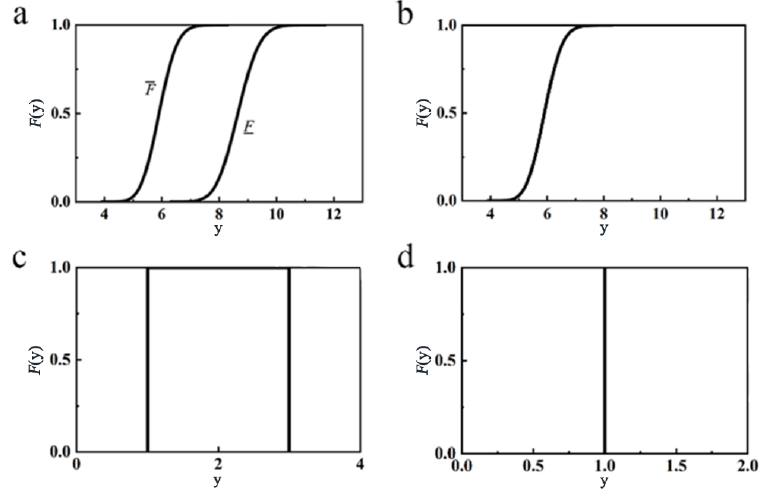
Figure 1. Sketch of the p-box and its special cases: ( a ) p-box considering aleatory and epistemic un- certainties; ( b ) p-box considering aleatory uncertainties; ( c ) p-box considering epistemic uncertainties; ( d ) p-box ignoring